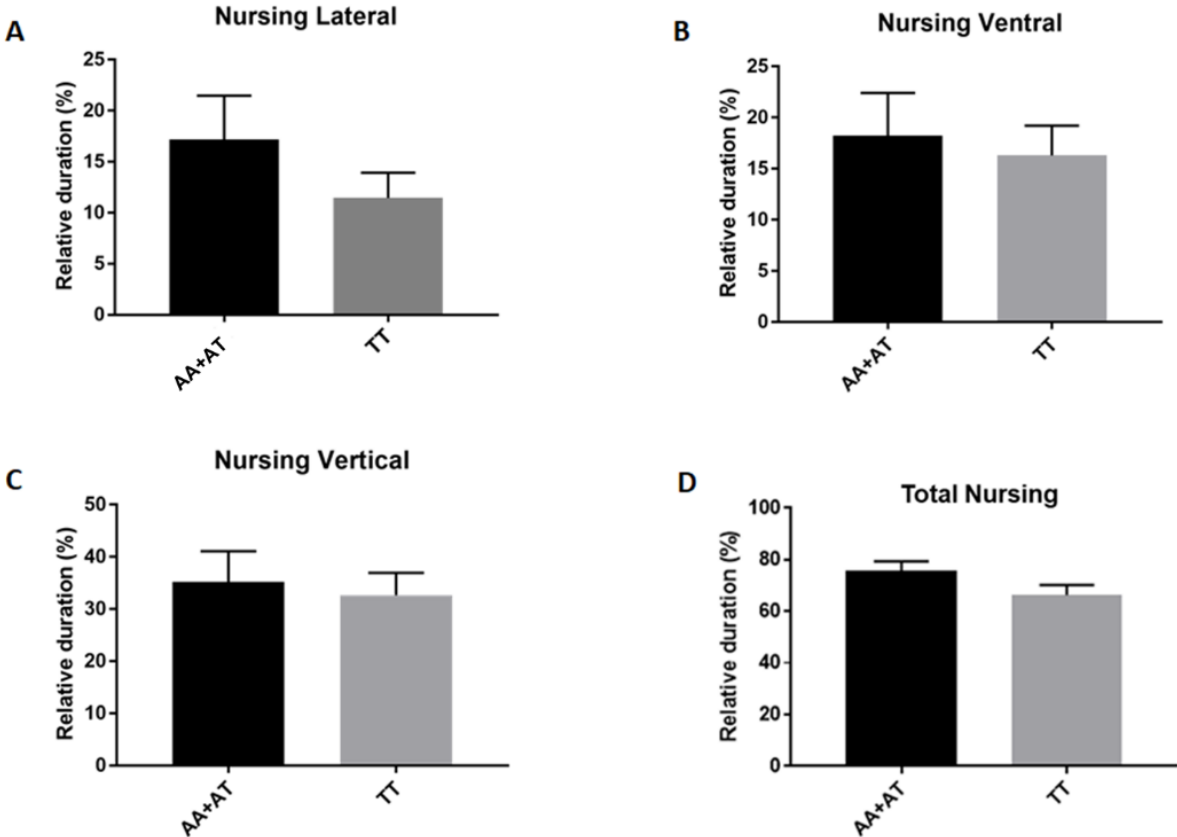
Figure 3. The A allele dams (AA + AT) tended to nurse more than homozygous T allele dams: ( A ) Nursing in lateral position, ( B ) Nursing in ventral position, ( C ) Nursing in vertical position, ( D ) Total Nursing = Nursing Lateral + Ventral + Vertical. The presence of the A allele (AA + AT) in rs 8679684 SNP was associated with a higher level of nursing lateral p = 0.2873, nursing ventral p = 0.4470, nursing vertical p = 0.2681 and total nursing p = 0.49319 ( p -values were calculated using Mann–Whitney test).